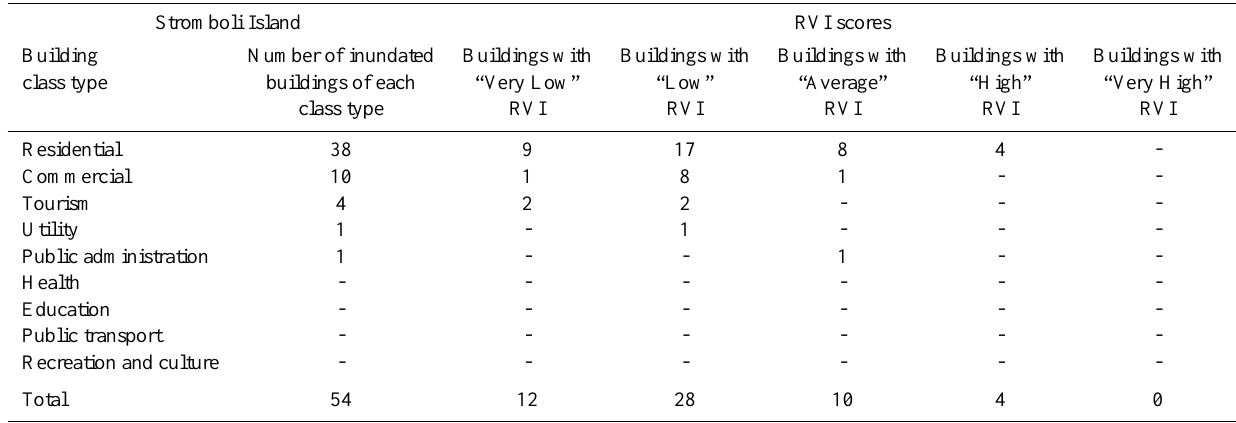
Table 3. Summary of the total number of buildings by building class and the number of buildings according to their Relative Vulnerability Index (RVI) scores in Stromboli